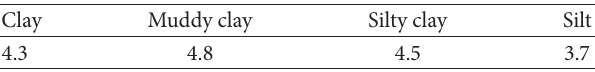
Table 3: The equivalent inertial force coefficient ( 𝑘 𝑡𝑖